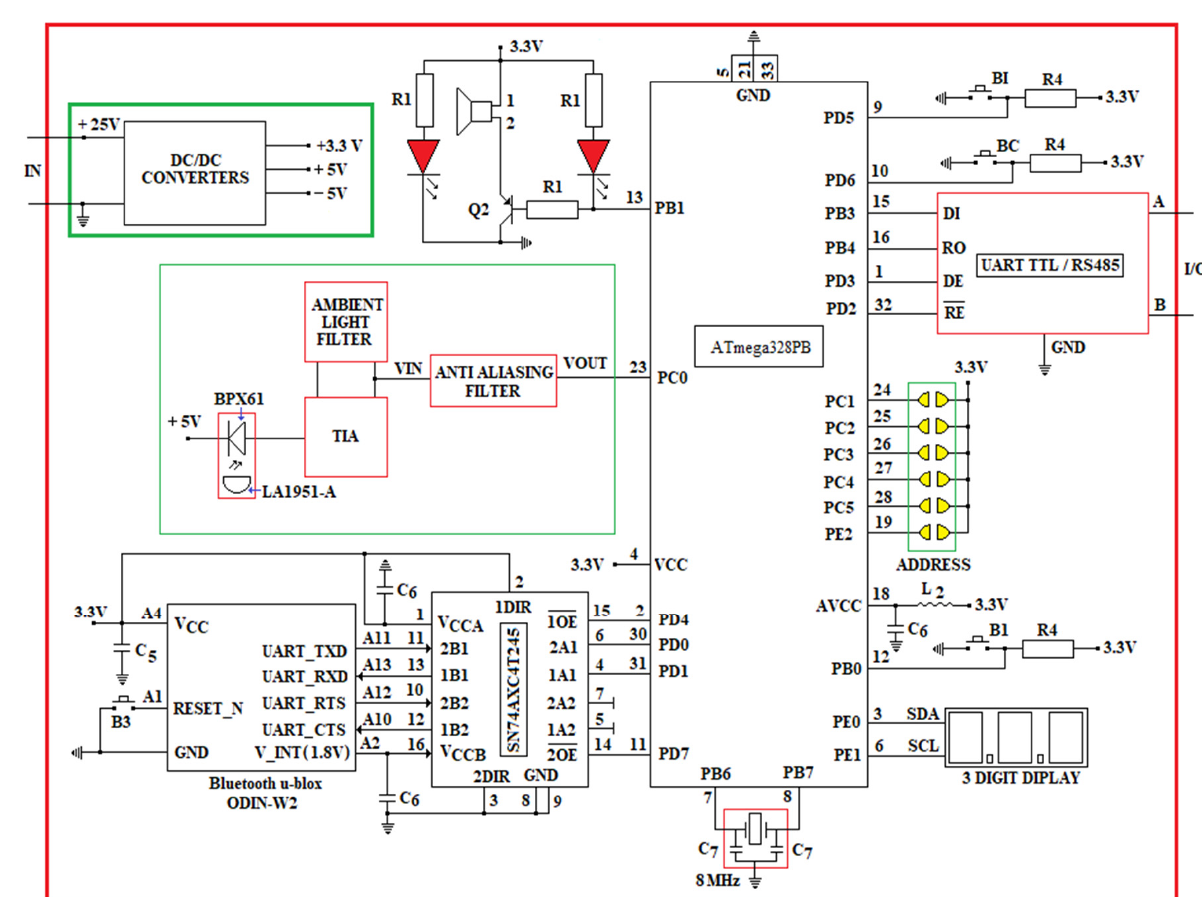
Figure 10. The oRx front end device aka the Access Point.